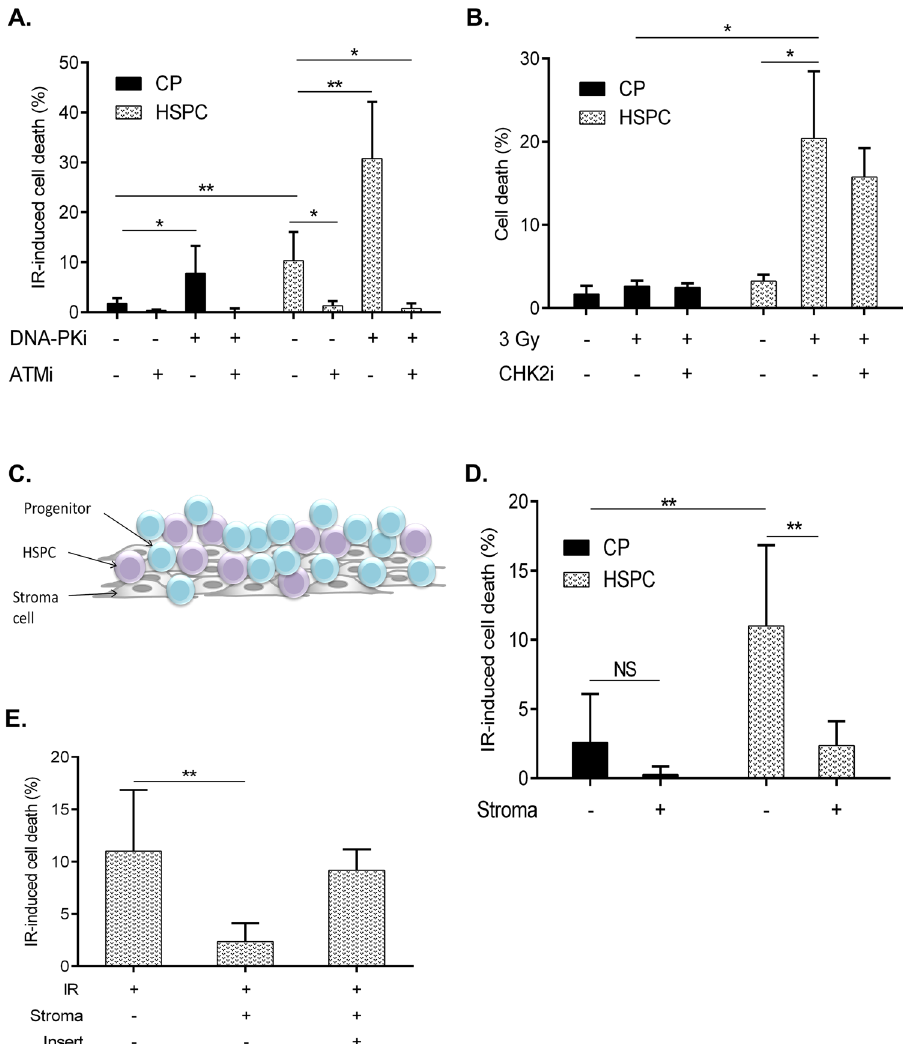
Figure 2. Regulation of IR-induced apoptosis in HSPCs and CPs. ( A) Freshly isolated CD34 + cells were pre- treated with ATMi (Ku60019, 10 μ M), DNA-PKi (Nu7441, 10 μ M) for 1 h, irradiated with 3 Gy and analyzed for cPARP + cells in HSPC and CP fractions 6 h later.n ≥ 4 (B) Freshly isolated CD34 + cells were pre-treated with CHK2i (PV1019, 10 μ M) for 1 h, irradiated with 3 Gy and analyzed for Annexin + cells in HSPCs and CPs 6 h later. n = 3 (C) Schematic presentation of OP9M2 stroma CD34 + co-culture system. (D) Freshly isolated CD34 + cells were irradiated (3 Gy) or not and immediately plated on pre-established confluent layers of OP9M2 stromal cells for 6 hrs followed by Annexin + cells analysis in HSPC and CP gates. IR-induced cell death was calculated to reduce the variability between CD34 + batches by subtracting the fraction of c-PARP + or AnnexinV + cells scored in the untreated sample from the same fraction in the IR sample n = 7 (E) CD34 + cells were plated on OP9M2 stroma as described in (D) in the presences or absence of pore (0.4 µ m) membrane insert, n ≥ 3. Represented are mean values ± SD, * p < 0.05, ** p <